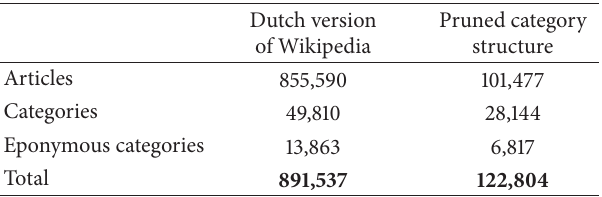
Table 1: Number of articles and categories in the Dutch version of Wikipedia and in the pruned category